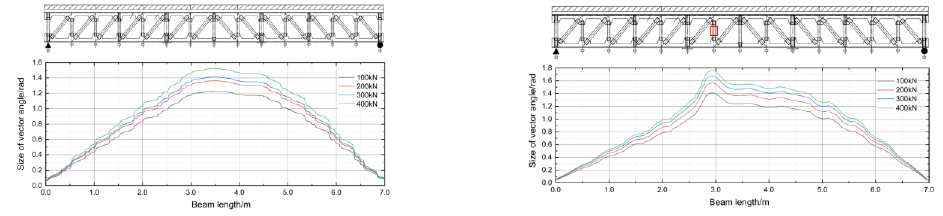
Figure 30. Schematic diagram of displacement vector’s rotation-angle change rate. To validate the proposed damage identification index, the rotation-angle distribution of the upper chord steel plate edge was extracted. Figure 31 shows the rotation-angle distribution curve of the upper chord steel plate edge.